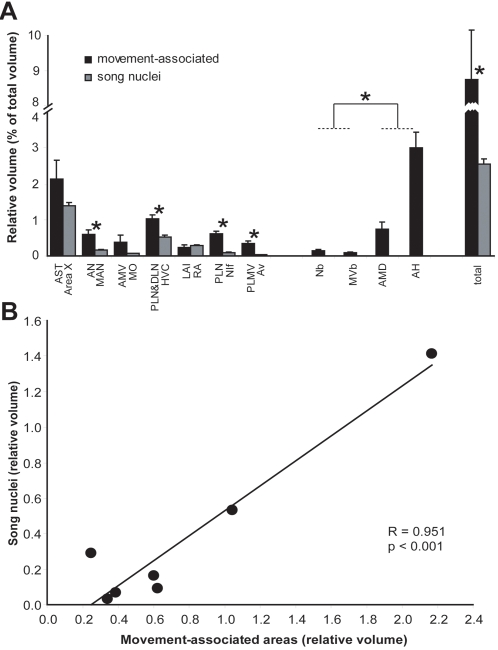
Relative volumes of movement-associated areas and vocal nuclei.A. Relative volumes as a percentage of the summed cerebral (telencephalon) volume from a series of sagittal sections (see methods) from the hopping, dark and deaf animals. The movement-associated areas and adjacent vocal nuclei are shown as bars adjacent to each other. Totals represent the summed relative volumes of all movement-associated areas whether or not it is adjacent to a vocal nucleus, and of all vocal nuclei. * = p<0.05, paired t-test (within bird comparisons, n = 3). Error bars, S.E.M. Although all animals had higher volumes of ASt and AMV relative to Area X and MO, the variance was large in the movement areas such that the volume difference did not reach significance. B. Correlation between relative volumes of movement-associated regions and adjacent vocal nuclei. Each dot represents the average values from the graph in (A).